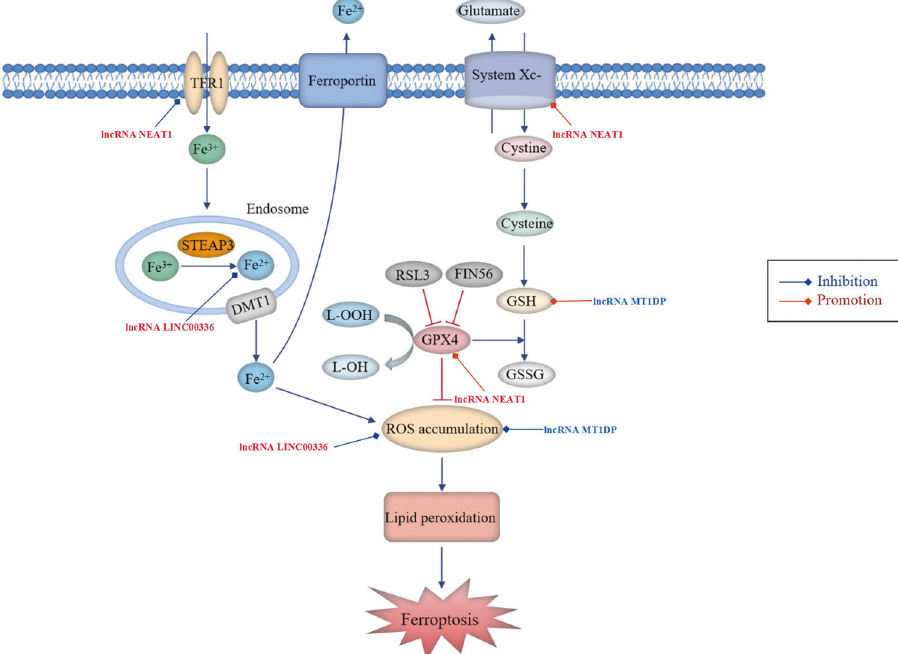
Fig. 5 LncRNAs participate in the regulation of ferroptosis in NSCLC. Ferroptosis is initiated by blockade of the cellular antioxidant defences depending on glutathione (GSH). Cystine/glutamate antiporter system Xc- is responsible for transporting intracellular glutamate to the outside of the cell and transferring extra-cellular cystine into the cell. Subsequently, cystine is converted into cysteine for the biosynthesis of GSH. GPX4 converts GSH into oxidized glutathione (GSSG), concurrent with cytotoxic lipid peroxide (L-OOH) reduced to the corresponding alcohol (L-OH), thus reducing ROS accumulation. Cellular uptake of circulating iron (Fe 3 + ) is mediated by TFR1 and intracellular iron can also be exported by ferroportin (FPN). The iron oxidoreductase six-transmembrane epithelial antigen of the prostate 3 (STEAP3) reduces Fe 3 + to Fe 2 + , the latter is released from the endosome via divalent metal transporter 1 (DMT1) and then delivered into the unstable iron pool, thereby leading to ROS generation. Aberrant accumulation of ROS ultimately results in lipid peroxidation and ferroptosis. Oncogenic lncRNAs (red font, high expression in NSCLC) and tumour-suppressive lncRNAs (blue font, low expression in NSCLC) participate in lung cancer-associated ferroptosis by regulating ferroptosis-related